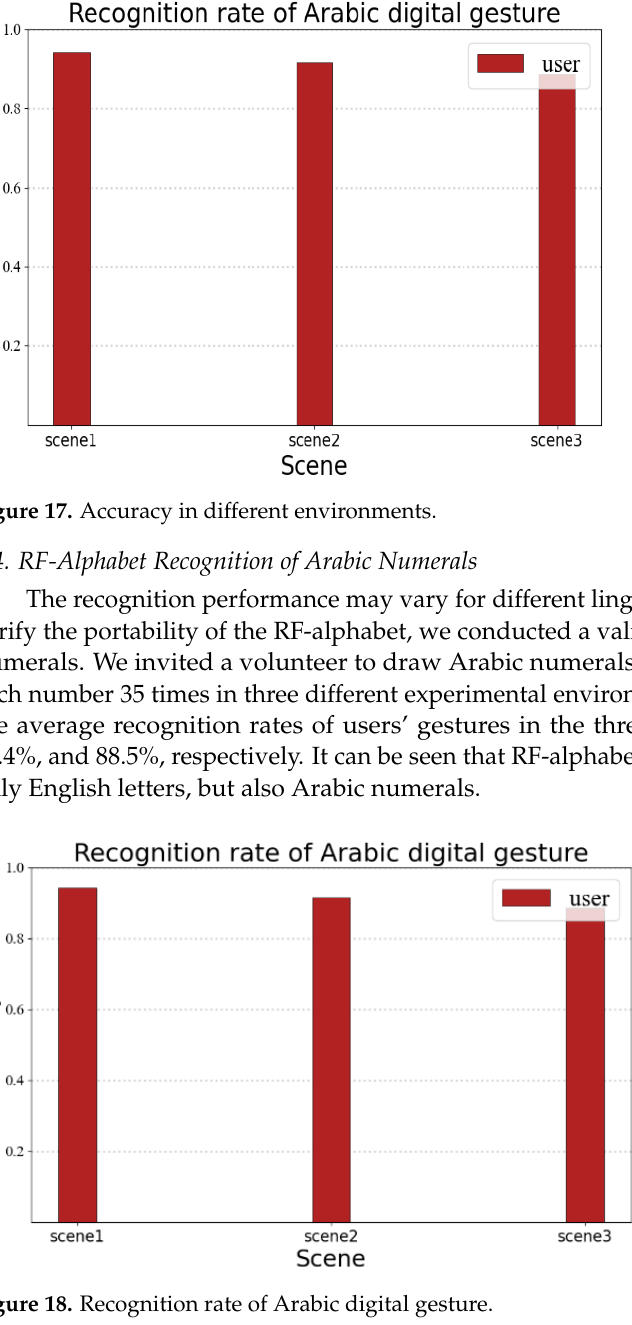
Figure 18. Recognition rate of Arabic digital gesture.